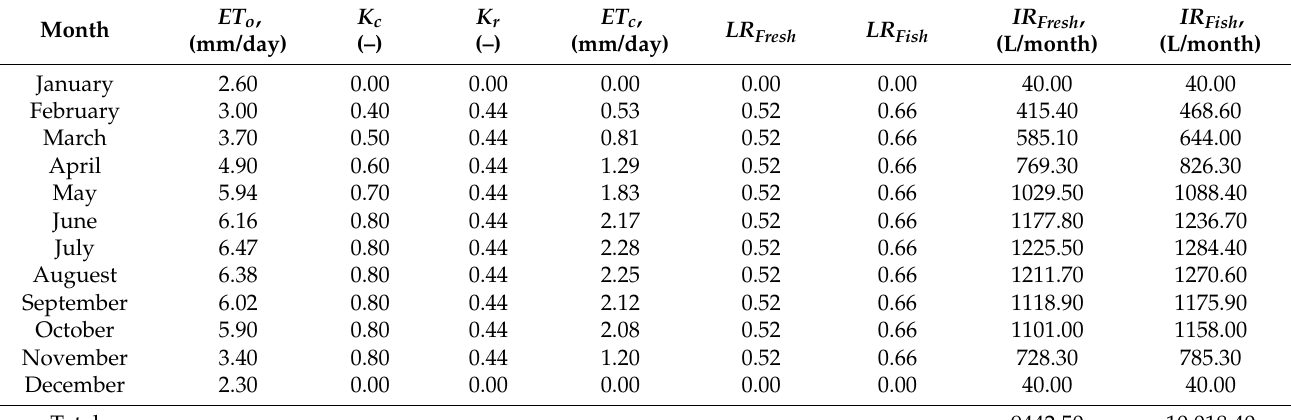
Table 4. Irrigation water requirements of pomegranate trees during the growing